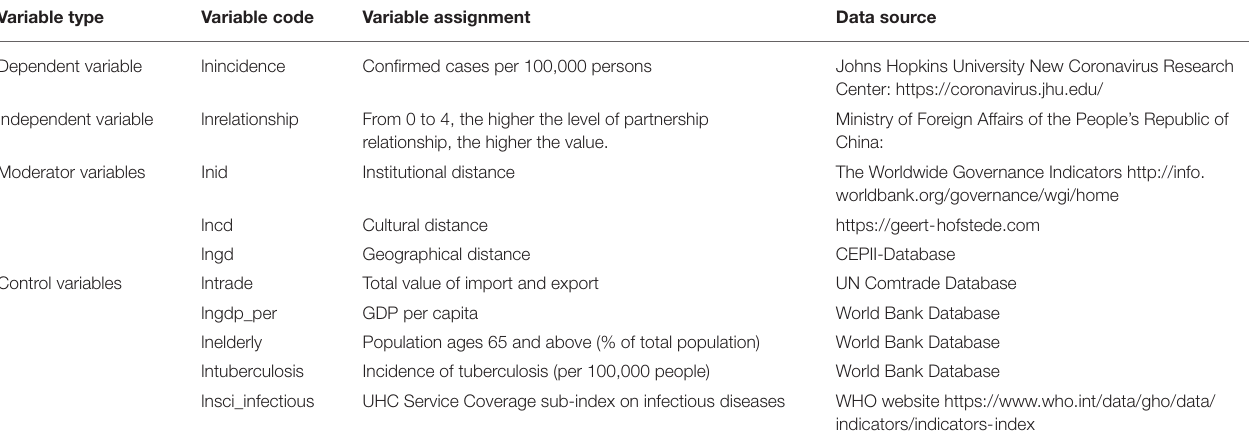
TABLE 1 | Variable definition and